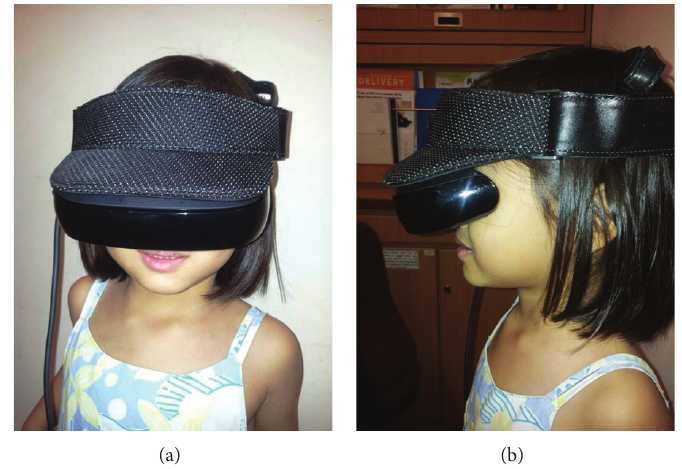
Figure 1: Child wearing HEADPLAY